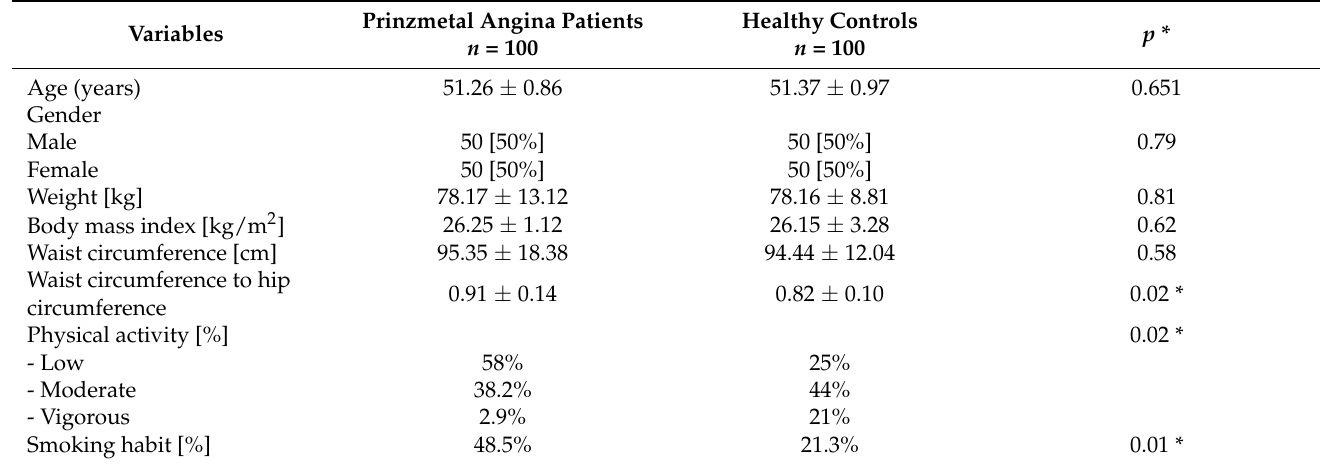
Table 1. General characteristics of study participants.